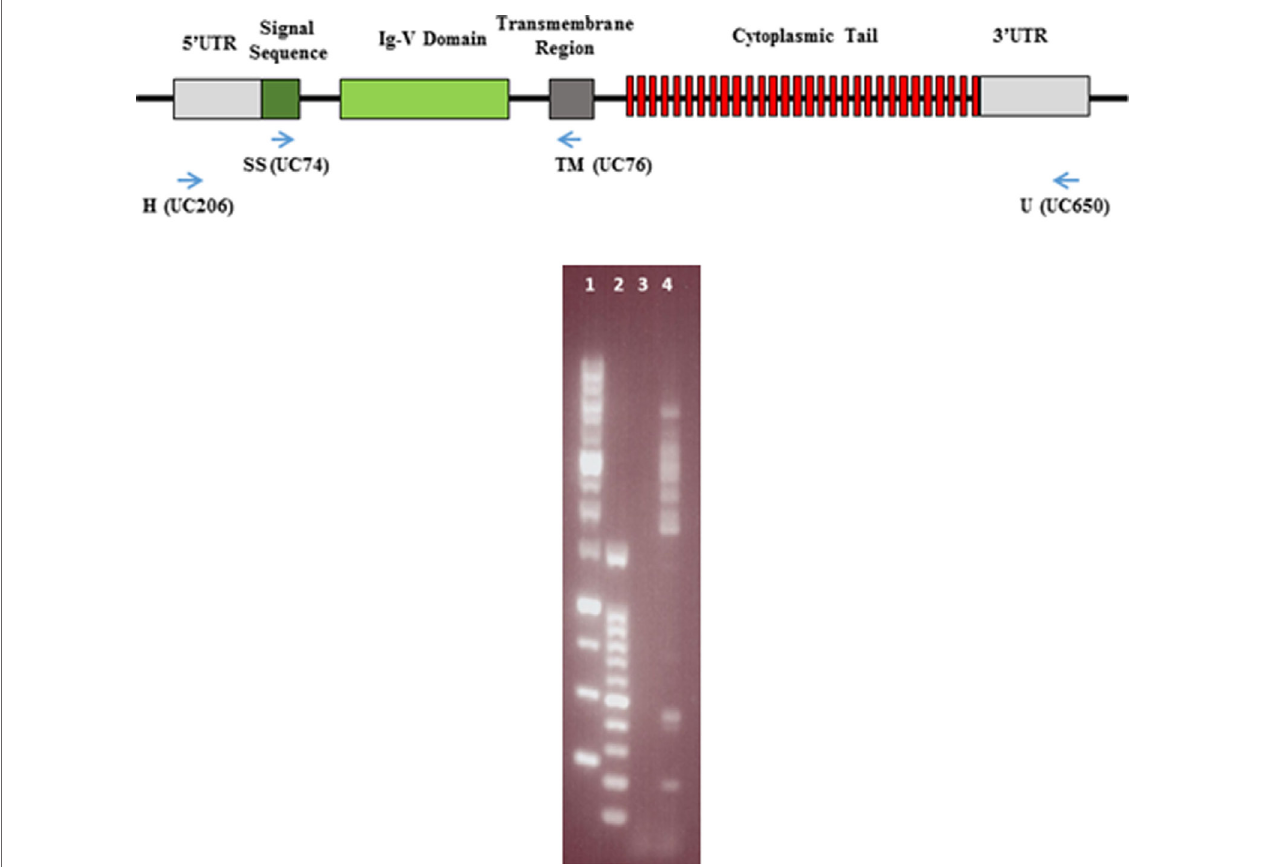
FigUre 1 | Representation of the intron–exon structure of a typical BG gene, with the encoded mRNA regions and protein domains indicated, as well as the location of the primers for the SS-TM and HU amplifications (top). Picture of agarose gel with the results of a representative amplification using HU primers (bottom). Lane 1, GeneDireX 1 kB markers (10, 8, 6, 5, 4, 3, 2.5, 2, 1.5, 1, 0.75, 0.5, and 0.25 kB); lane 2, GeneDireX 100 bp markers (1500, 1000, 900, 800, 700, 600, 500, 400, 300, 200, and 100 bp); lane 3, no template control PCR; lane 4, PCR with line N T cell